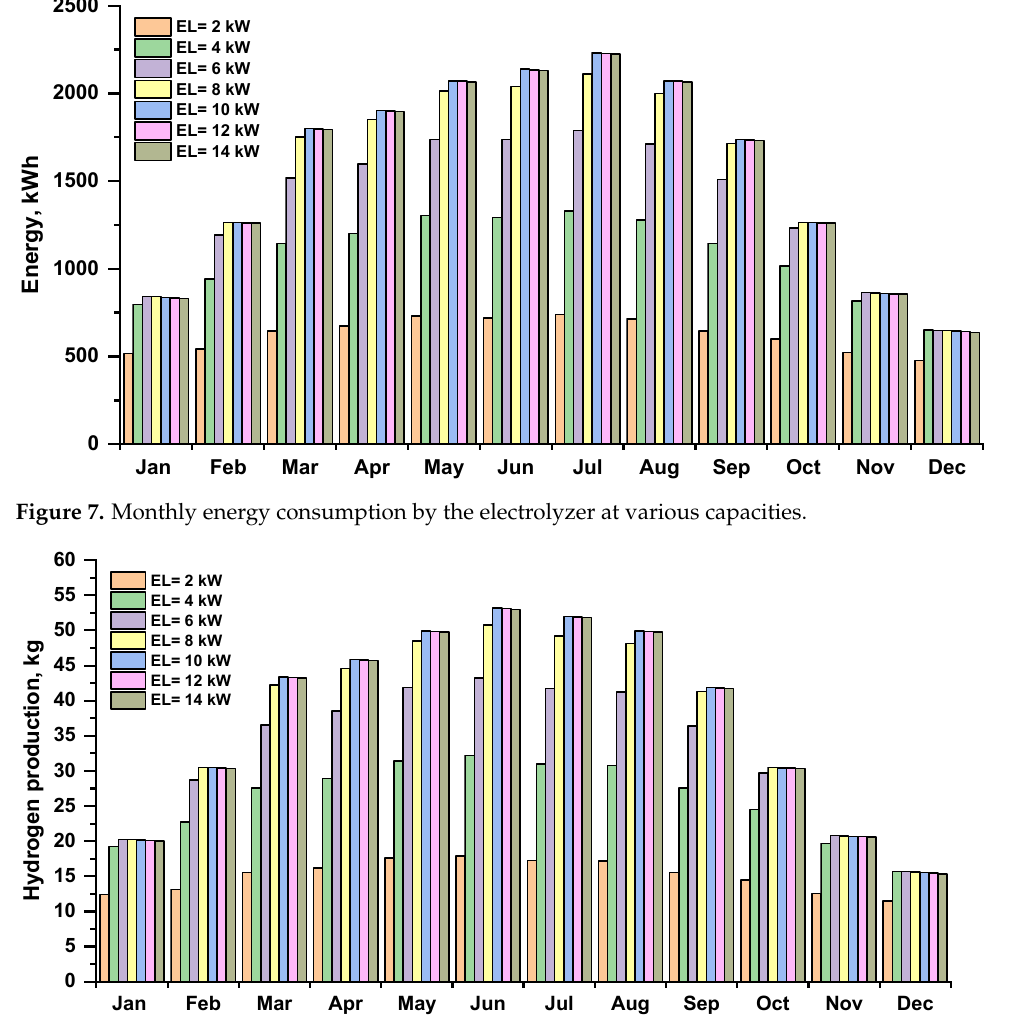
Figure 8. Monthly hydrogen production by an electrolyzer at several capacities.